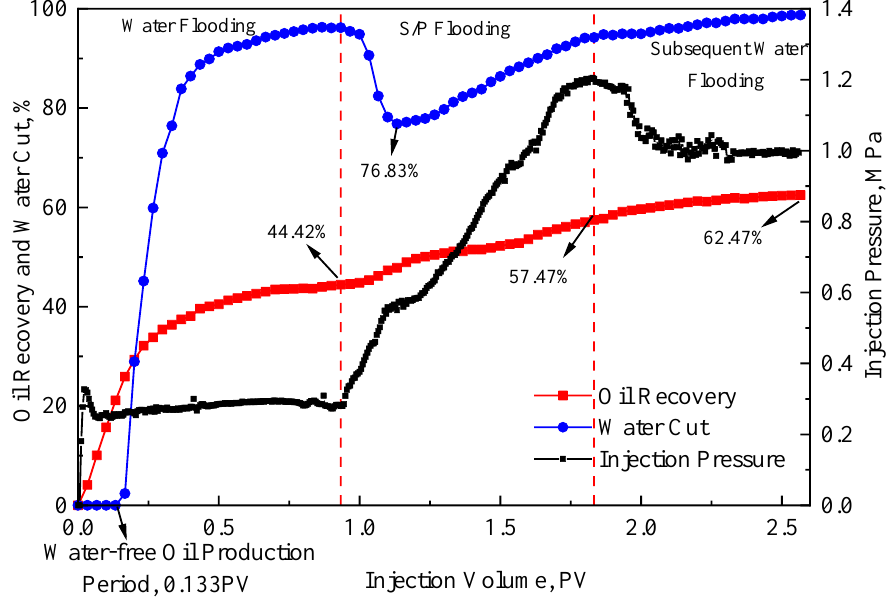
Figure 14. The injection pressure, water cut, and oil recovery of S/P flooding of inverted seven-spot well pattern.